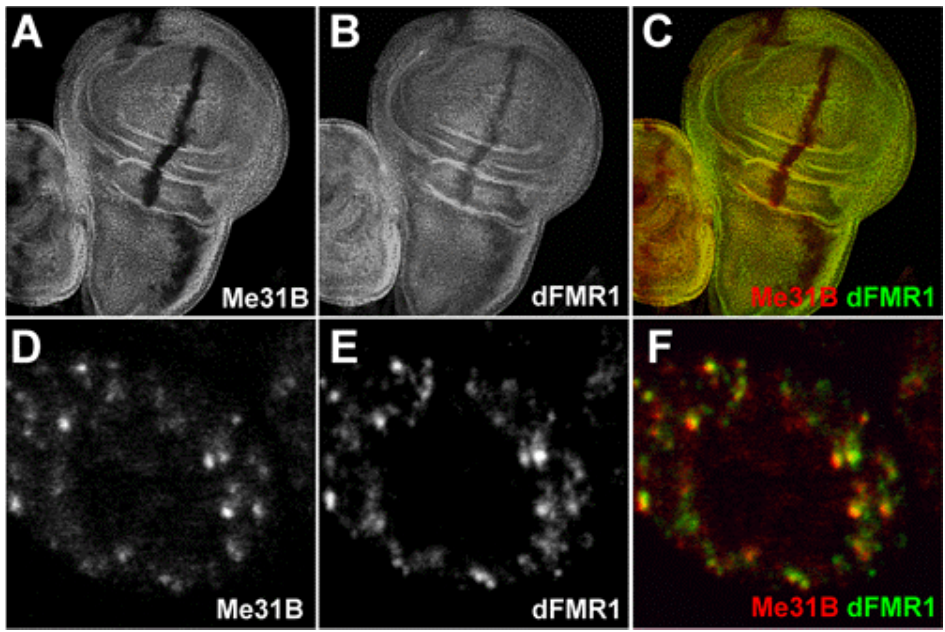
FIGURE 3 . Depletion of Me31B reduces dFMR1 expression in wing imaginal discs, and Me31B and dFMR1 colocalize in P-bodies. (A–C) The loss of P-bodies in the wing imaginal disc by depletion of Me31B affects the recruitment of dFMR1 into foci. A Me31B hairpin construct[12] was expressed with patched-Gal4, reducing Me31B expression at the anterior/posterior boundary of the wing imaginal disc (marked by the absence of Me31B protein, A). For these experiments, wing discs of 3rd instar larvae were dissected, fixed with 4% formaldehyde and double stained with α -Me31B[43] and α -dFMR1 (5A11, Developmental Studies Hybridoma Bank). (D–F) In Drosophila Schneider, cells Me31B and dFMR1 colocalize in cytoplasmic foci, previously shown to be P-bodies (JH and MR, unpublished). For these experiments, Drosophila Schneider line 2 cells (S2) growing in M3 medium (Sigma) on glass cover slips were fixed with 4% Paraformaldehyde and counterstained with α -Me31B[43] and α -dFMR1 (5A11, Developmental Studies Hybridoma Bank).